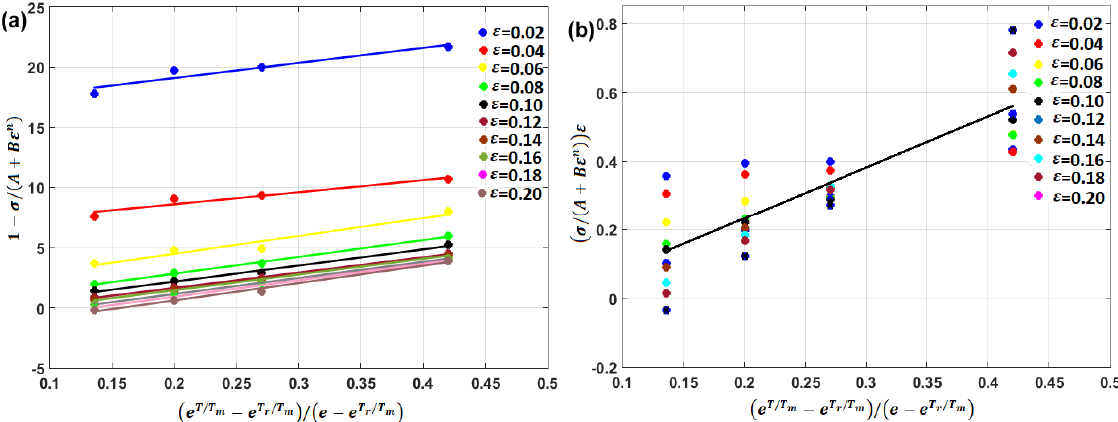
Figure 17. Determination of ( a ) λ and ( b ) 𝜆 ′ using regression analysis.